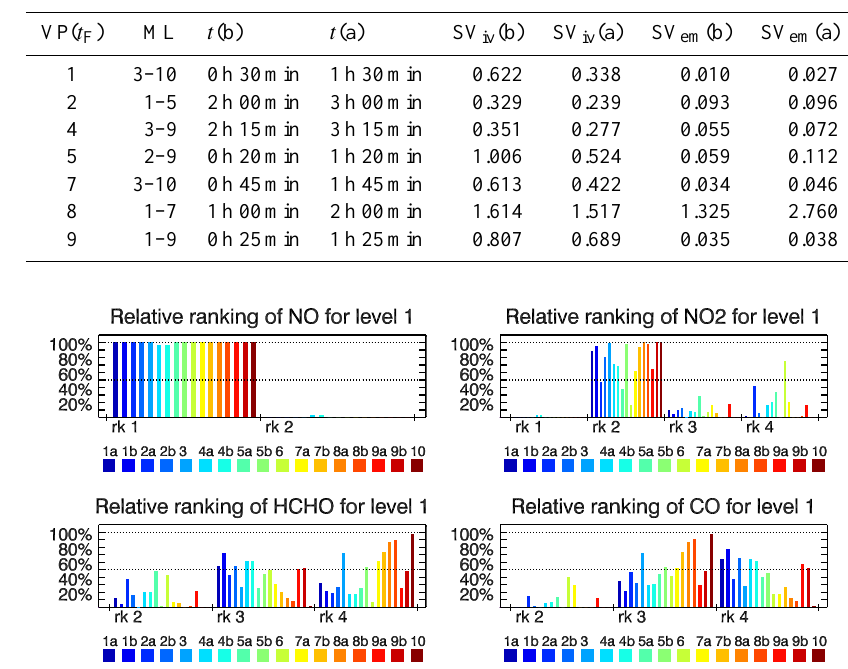
Figure 8. Relative ranking of the first singular vector with respect to emission uncertainties. Illustrated are results for NO (top left), NO 2 (top right), HCHO (bottom left), and CO (bottom right) at surface level for all 17 case studies. Plotting conventions as in Fig.